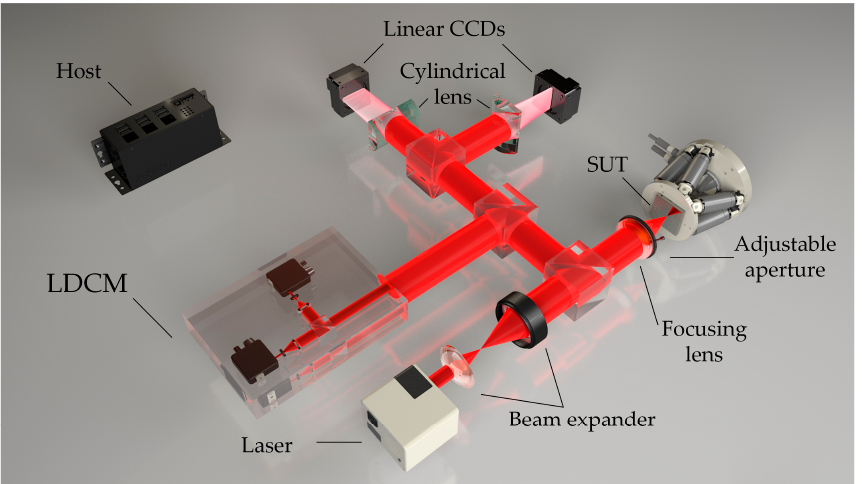
Figure 5. Schematic of a laser differential confocal microscope using the reported two measurement units whose spatial positions are orthogonal to each other. Each measuring unit comprises a cylindrical mirror and a linear charge-coupled device (CCD).